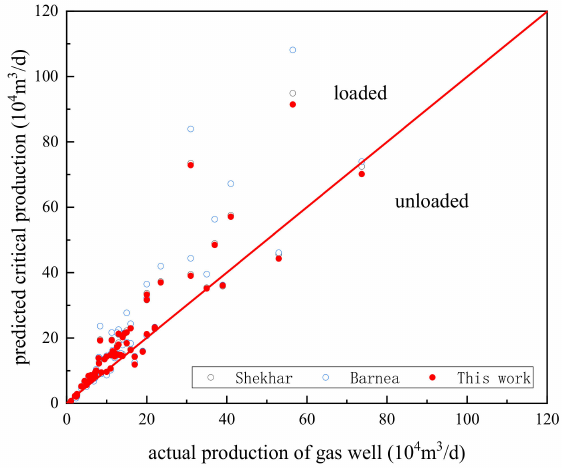
Figure 17. Comparison of prediction results of each model (Veeken